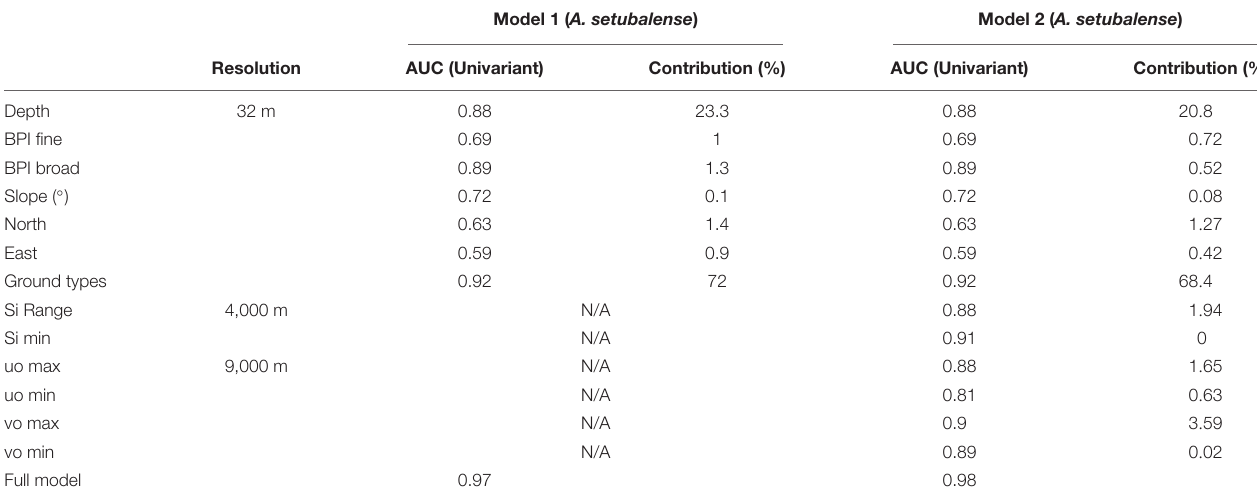
FIGURE 5 | Backscatter of ACS (A) and El Cachucho MPA (B) , and Ground types layer (C) extracted by backscatter values validated by images ground truthing and sediment studies. TABLE 1 | MaxEnt univariate models AUC and contribution of each variable for two models: Model 1, constructed only with geomorphological variables; and Model 2, which includes the physicochemical variables of currents and silicates. Model 1 ( A. setubalense ) Model 2 ( A. setubalense )